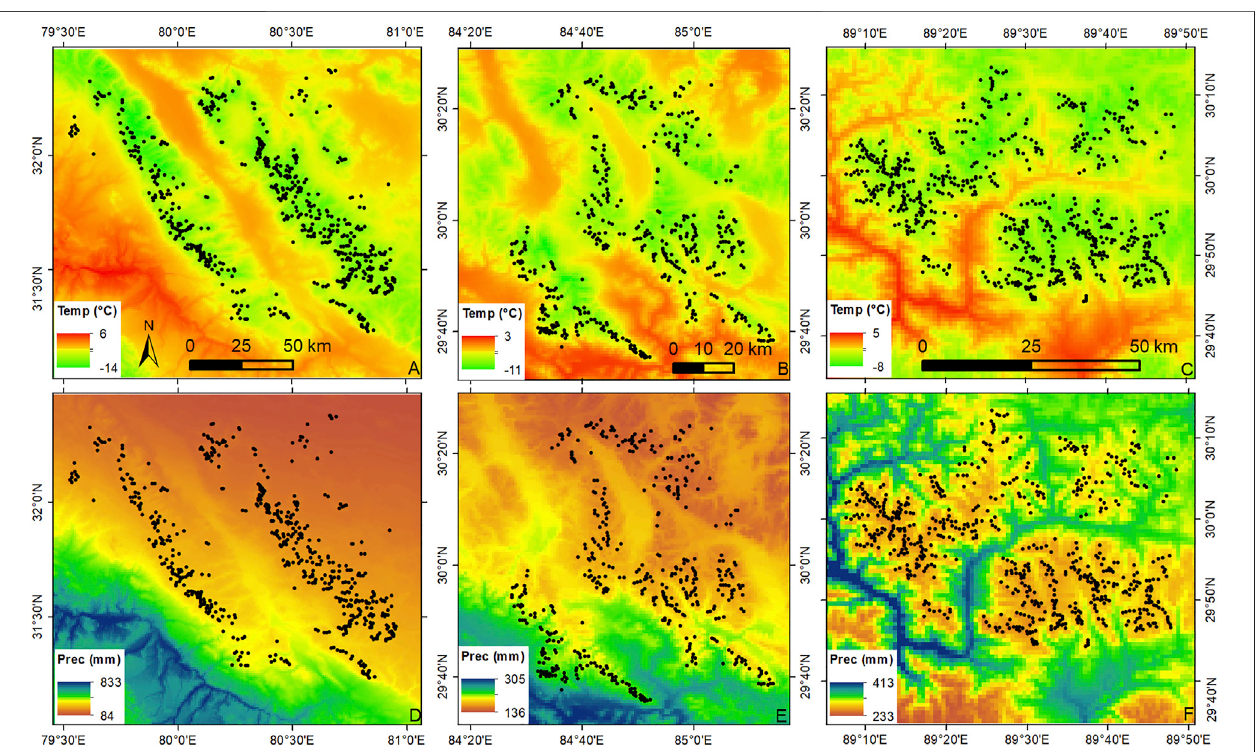
FIGURE 2 | Annual temperatures and precipitations in the Gangdise Mountains ’ western (A,D) , central (B,E) and eastern (C,F) parts. Cirque locations are shown by black dots. Data from https://www.worldclim.org/data/worldclim21.html (Fick et al., 2017)